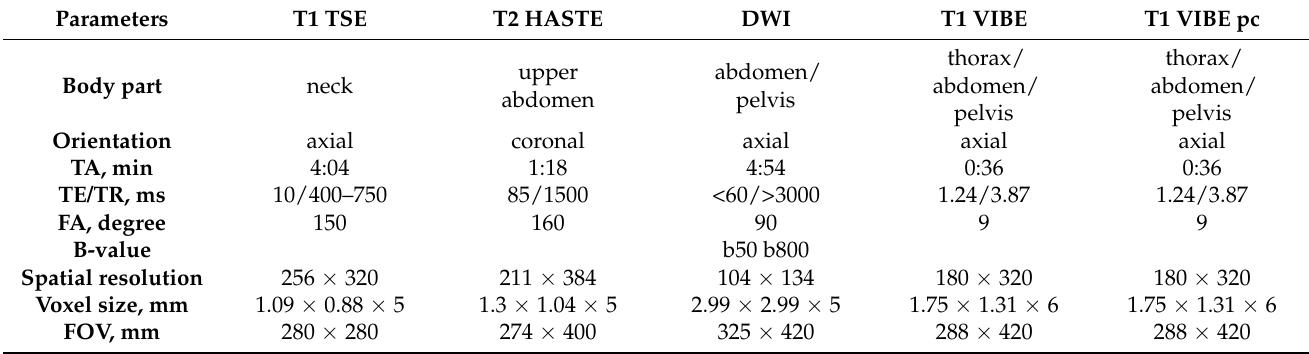
Table 2. Acquisition parameters of the accelerated whole-body MRI